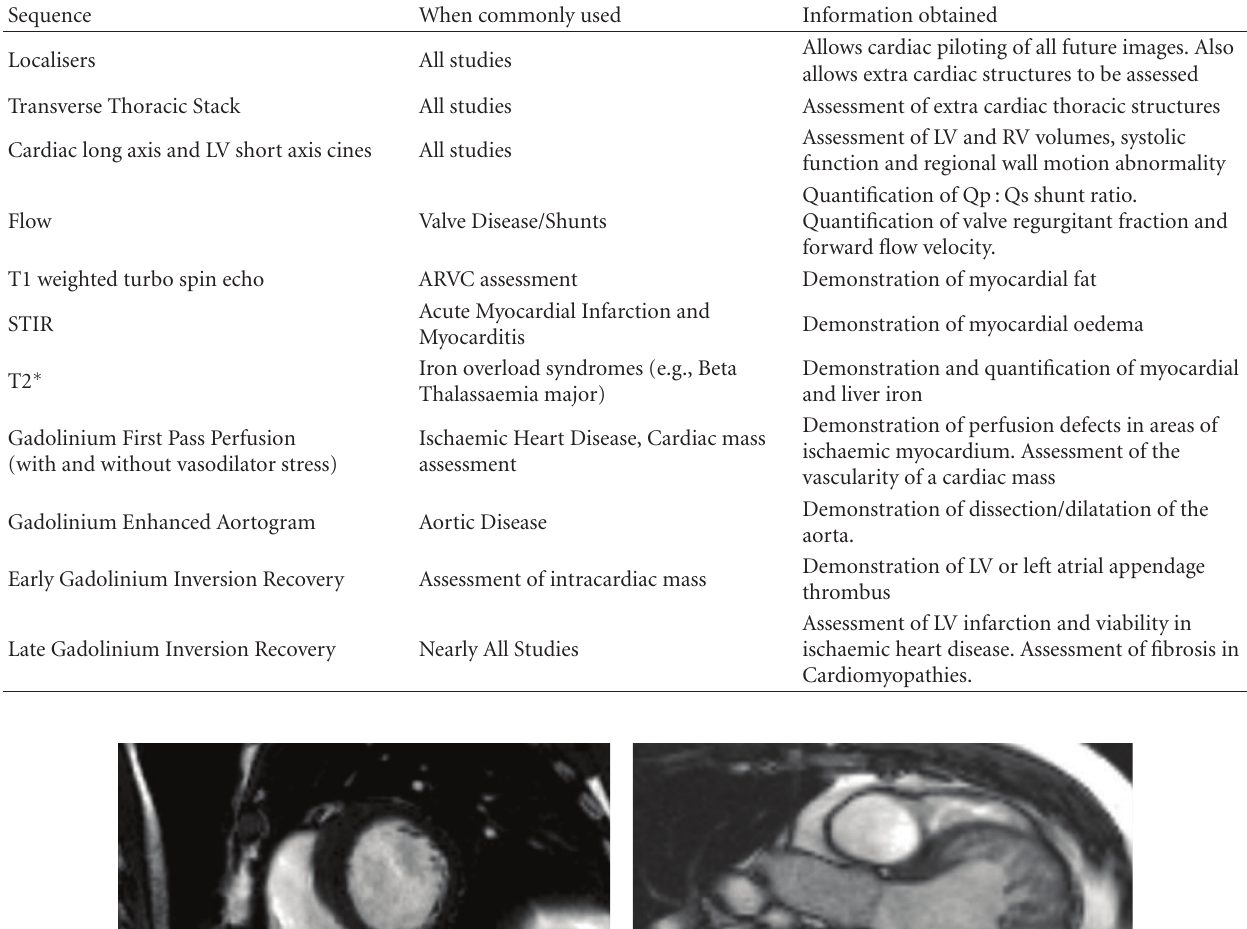
Table 1: Sequences commonly employed during a CMR examination.